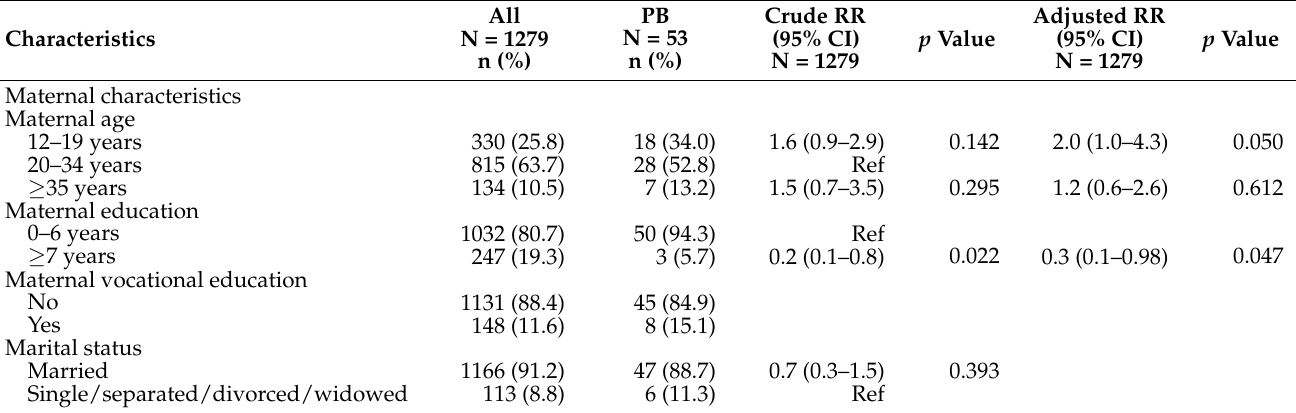
Table 4. Bivariable and multivariable analysis of risk factors for preterm birth in northern